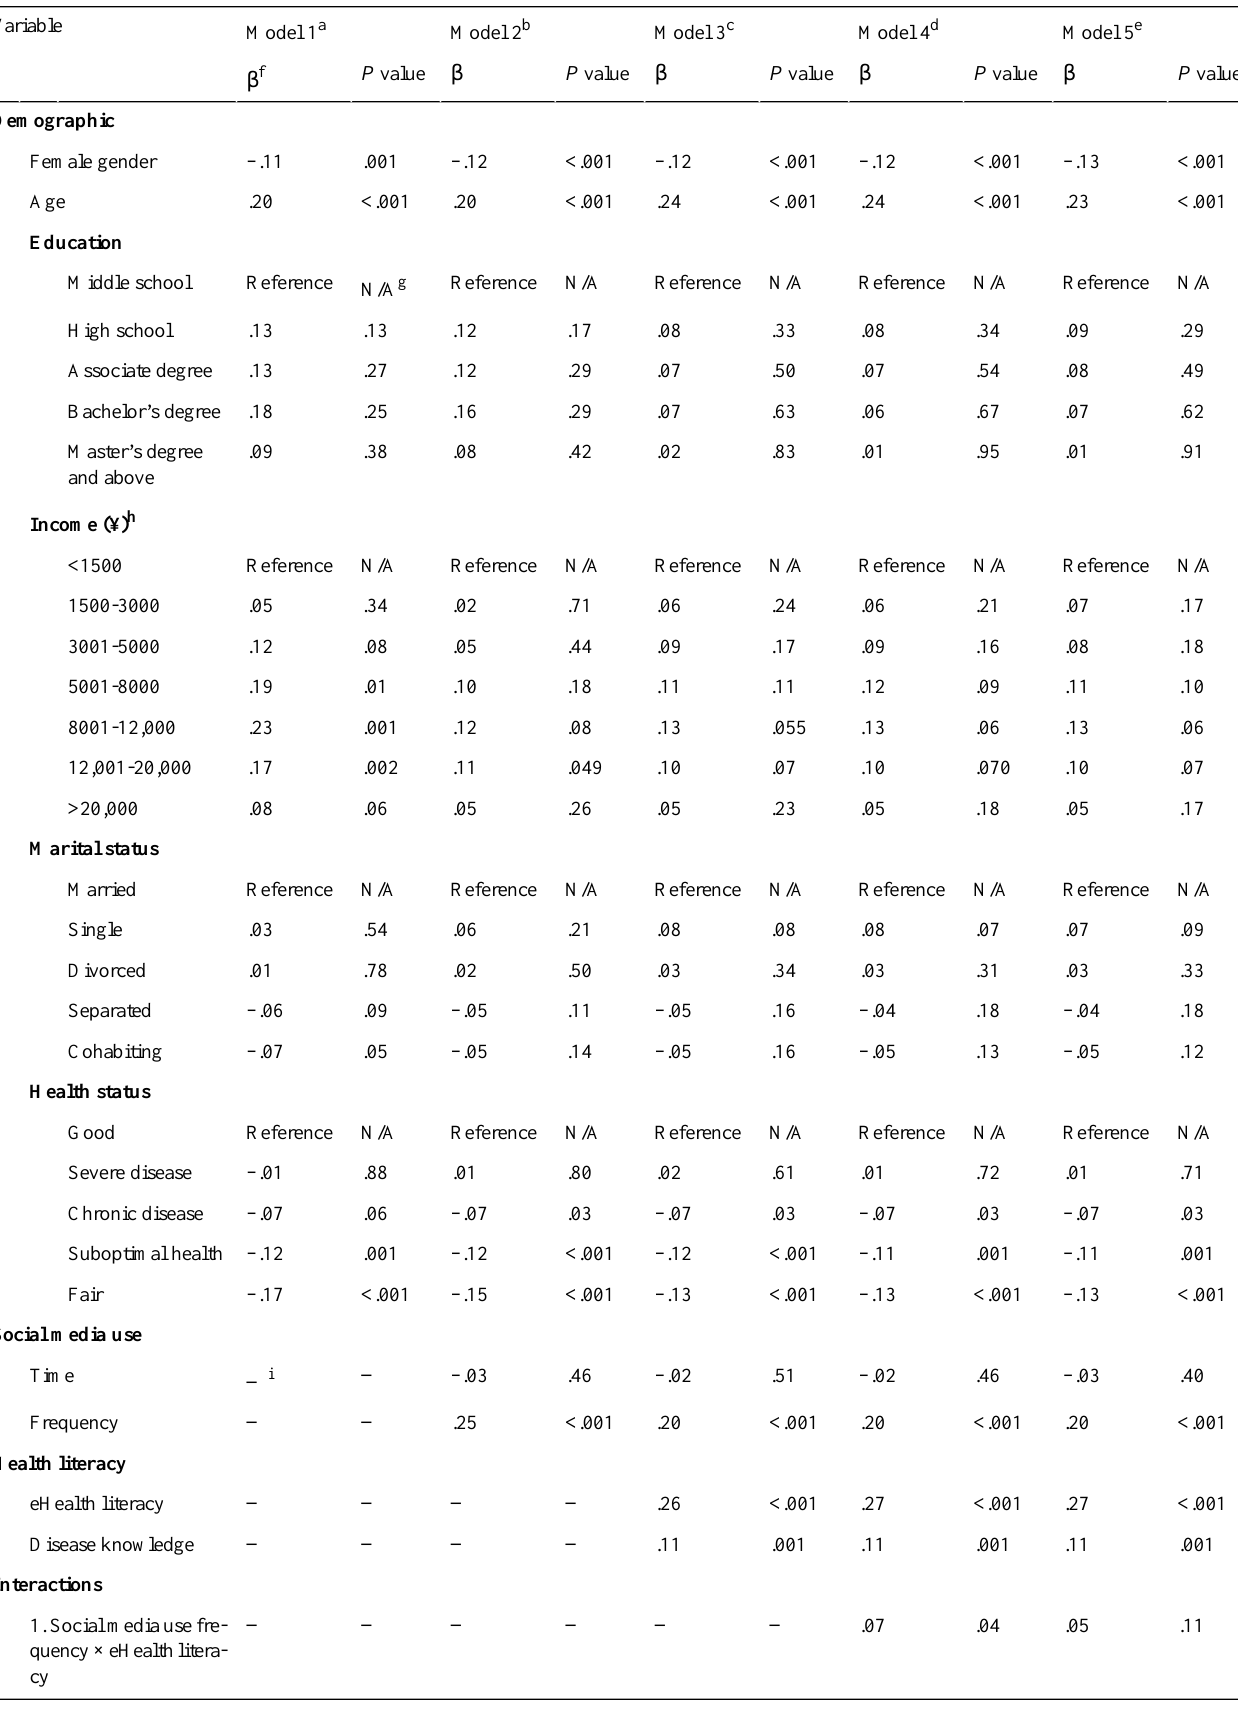
Table 3. Hierarchical multiple regression examining the predictors and moderators of preventive behaviors during the COVID-19